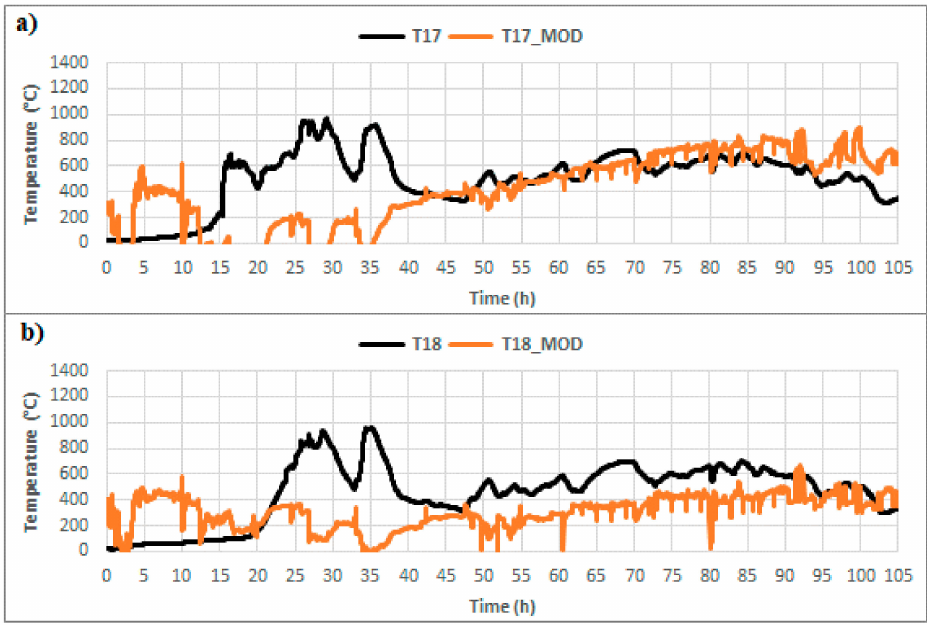
Figure 16. The measured (T) and modeled (T_MOD) temperature behavior in the second phase verification, ( a ) temperature T 17 , ( b ) temperature T 18 (Source: own